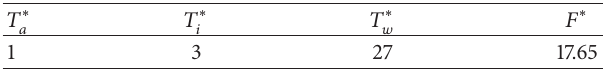
Table 3: Optimal parameters and objective function values when both 𝑇 𝑠 and 𝑇 𝑑 follow certain